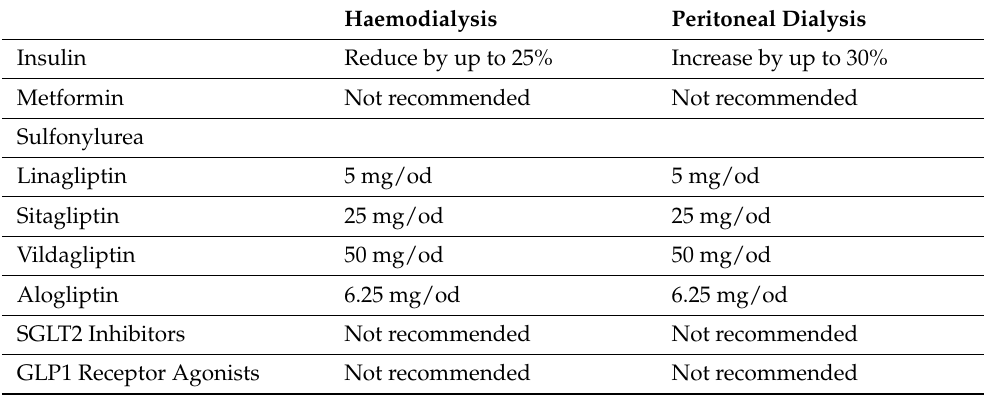
Table 1. Recommended dose adjustments in diabetes medications at start of